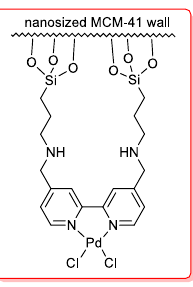
Figure 6. Nanosized MCM-41-Pd as catalyst for acyl Sonogashira reactions.